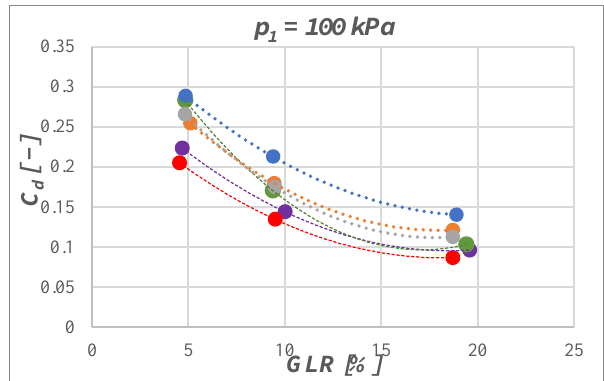
Fig. 11. The influence of GLR on C d for p 1 = 100 kPa .